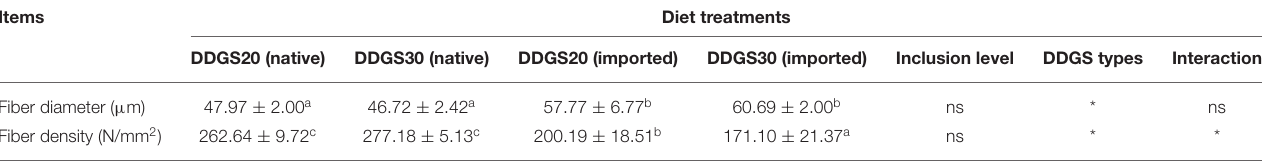
TABLE 9 | The effects of different types and levels of dietary DDGS on muscle cellularity a . Items